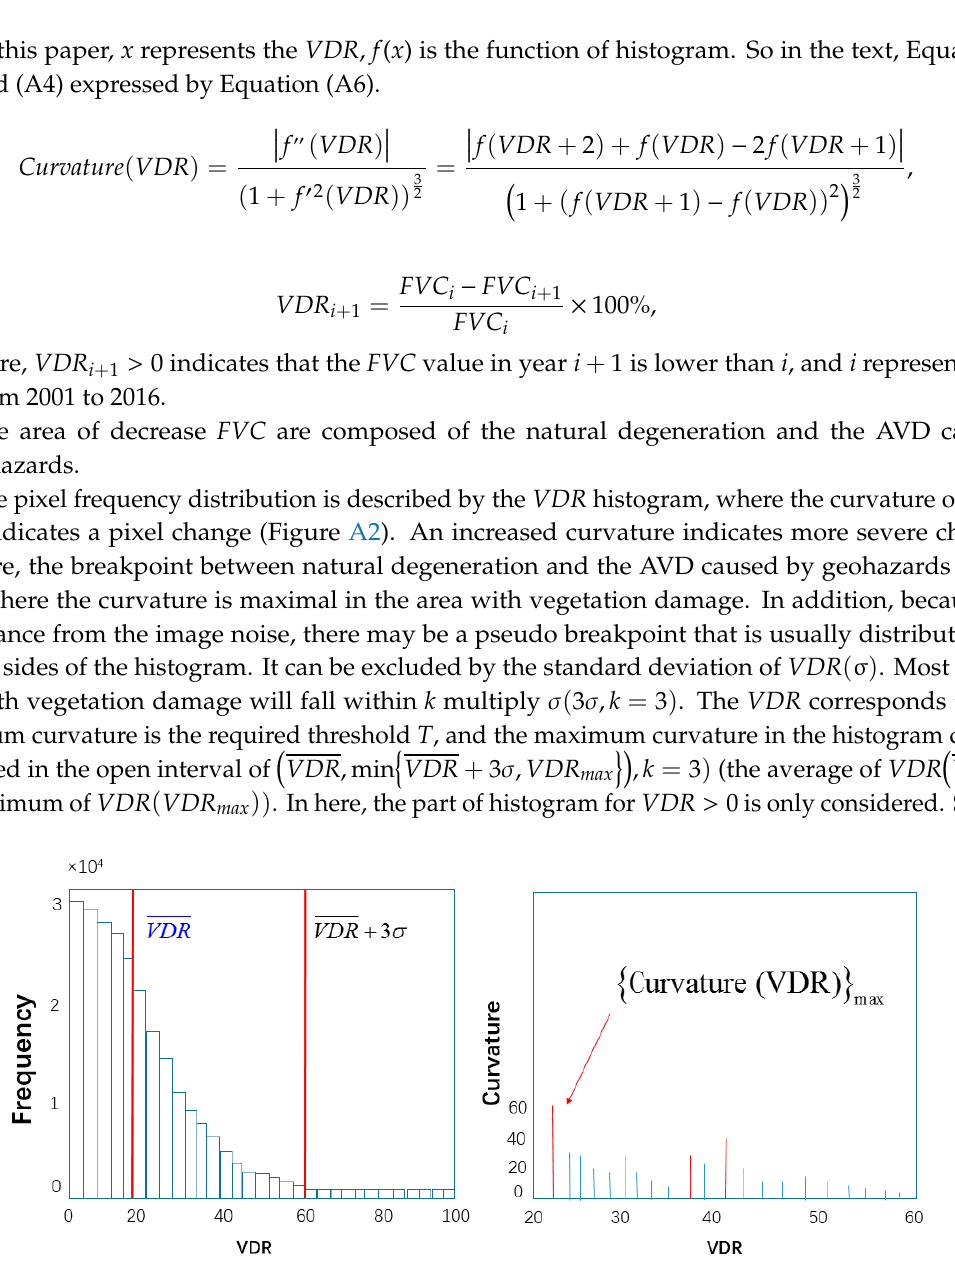
Figure A2. Frequency function of VDR histogram ( left ) and Curvature function of VDR histogram ( right ).